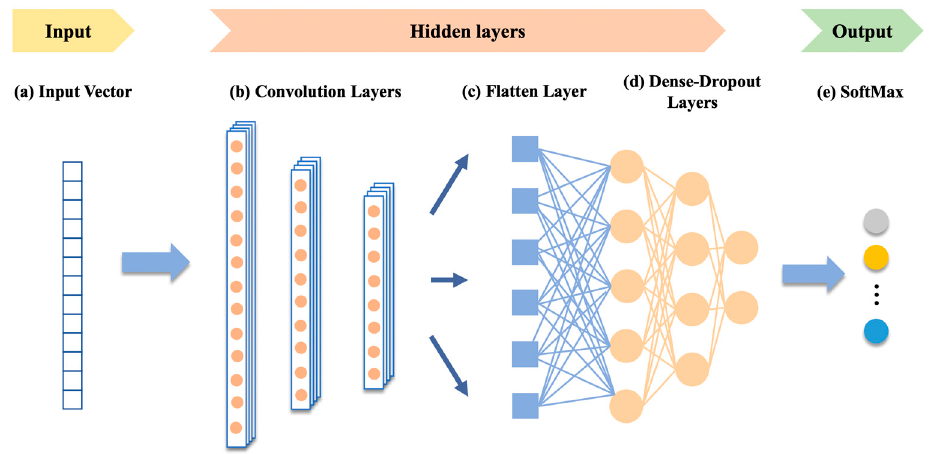
Figure 9. 1DCNN structure. The structure of 1DCNN mainly includes input, hidden layer, and output, so as to achieve the purpose of feature